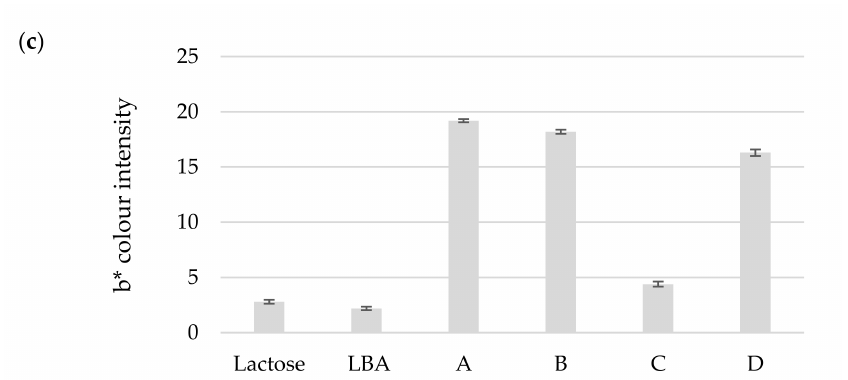
Figure 4. Results of color analysis of “Pa Panreac” lactose, “Sigma-Aldrich” lactobionic acid (LBA) and lactobionic acid samples. ( a ) L * coordination of white-black color; ( b ) a * coordination of red-green color; ( c ) b * coordination of yellow-blue color.